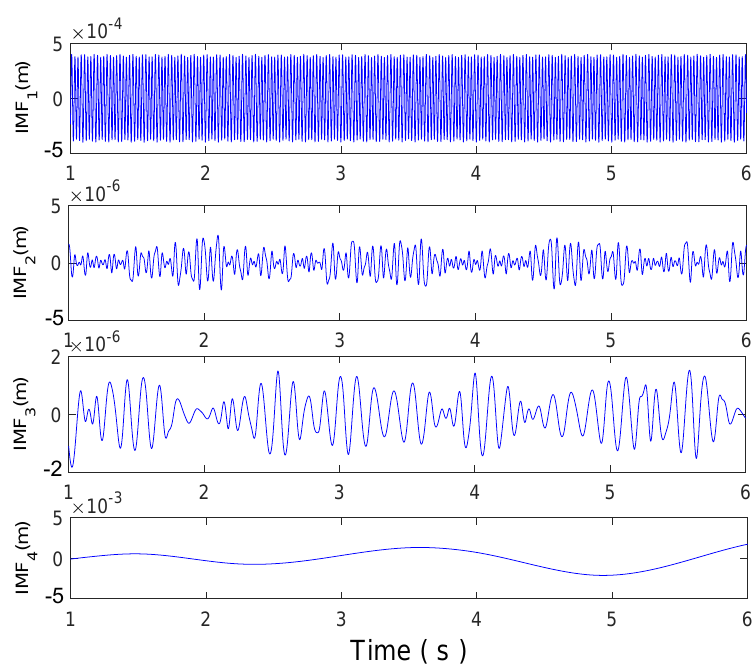
Figure 12. High frequency class: IMF 1 , IMF 2 , IMF 3 and low frequency class IMF 4 extracted from ξ y .